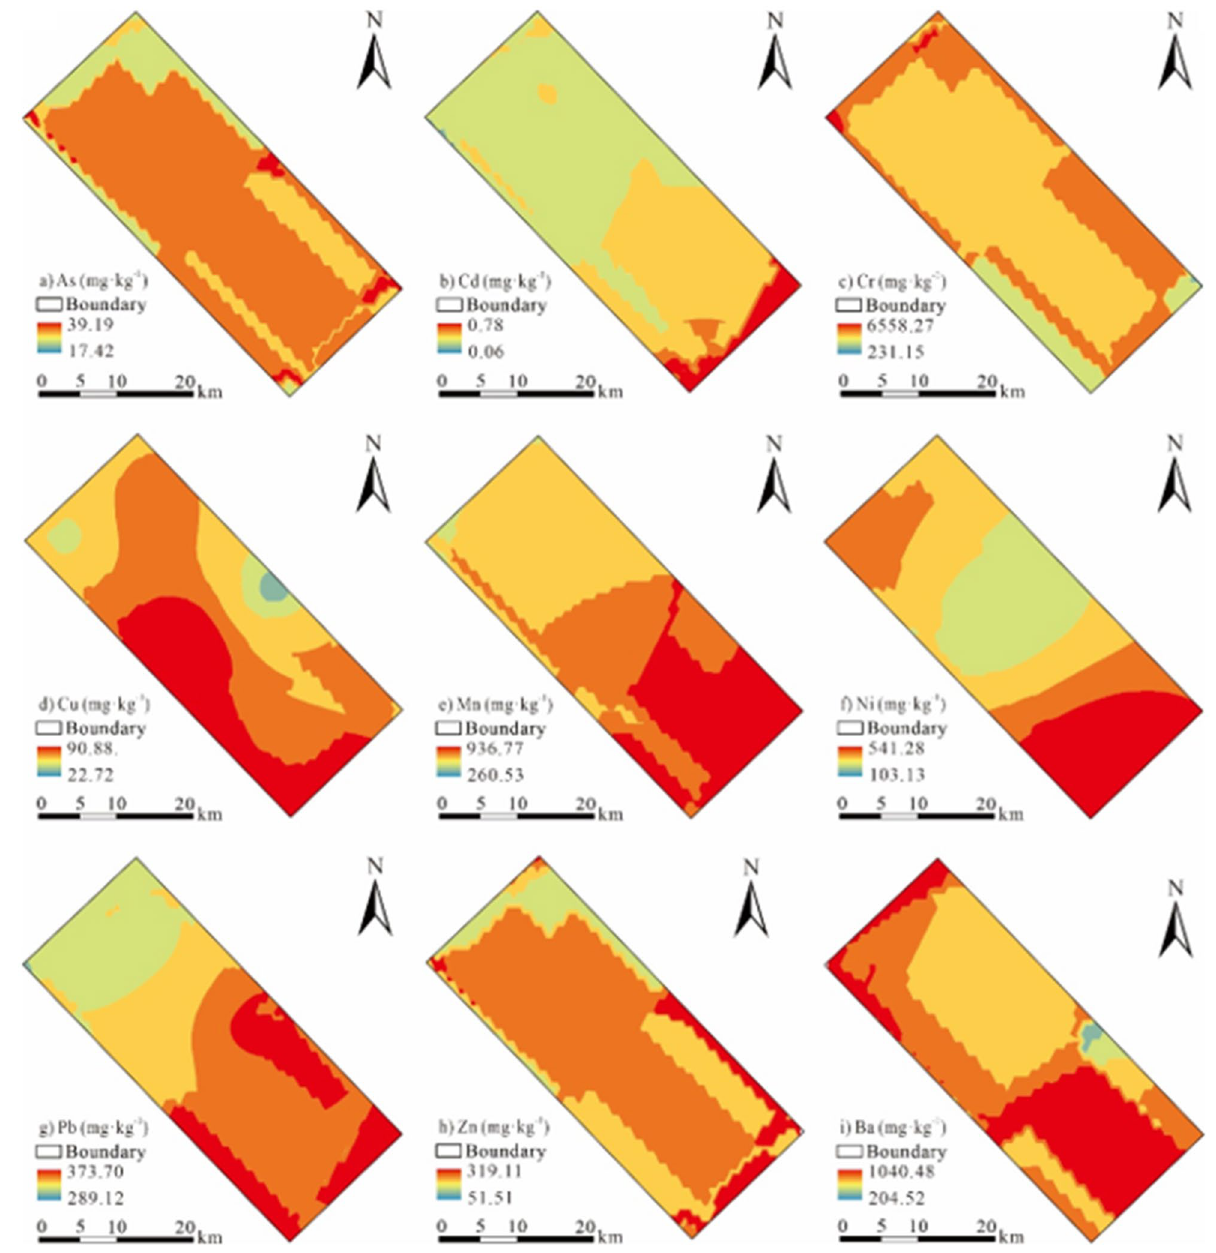
Figure 3. spatial distribution map of soil PTEs in the study